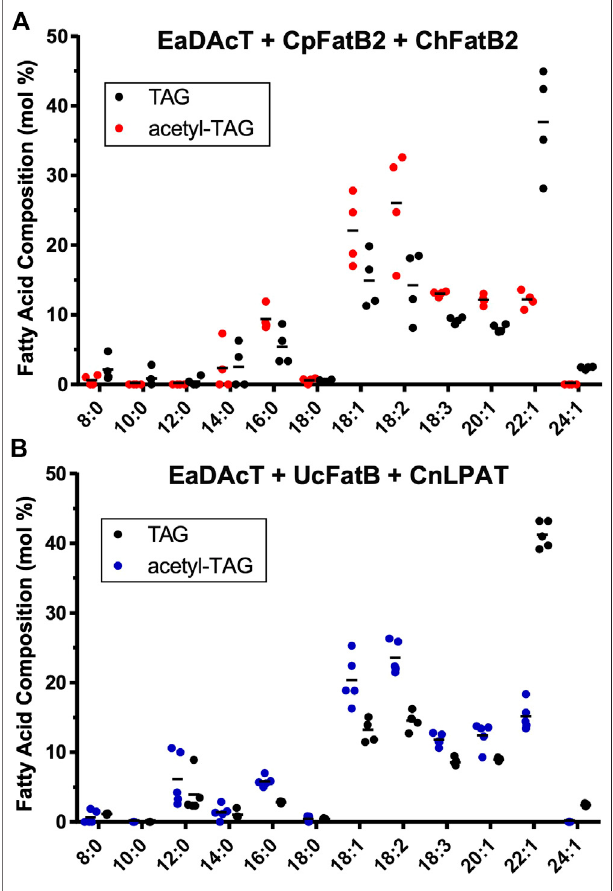
FIGURE 7 | Fatty acid composition of acetyl-TAG and TAG extracted from F 3 seeds of lines expressing EaDAcT in combination with (A) CpFatB2 + ChFatB2 or (B) UcFatB + CnLPAT . Horizontal lines represent the mean